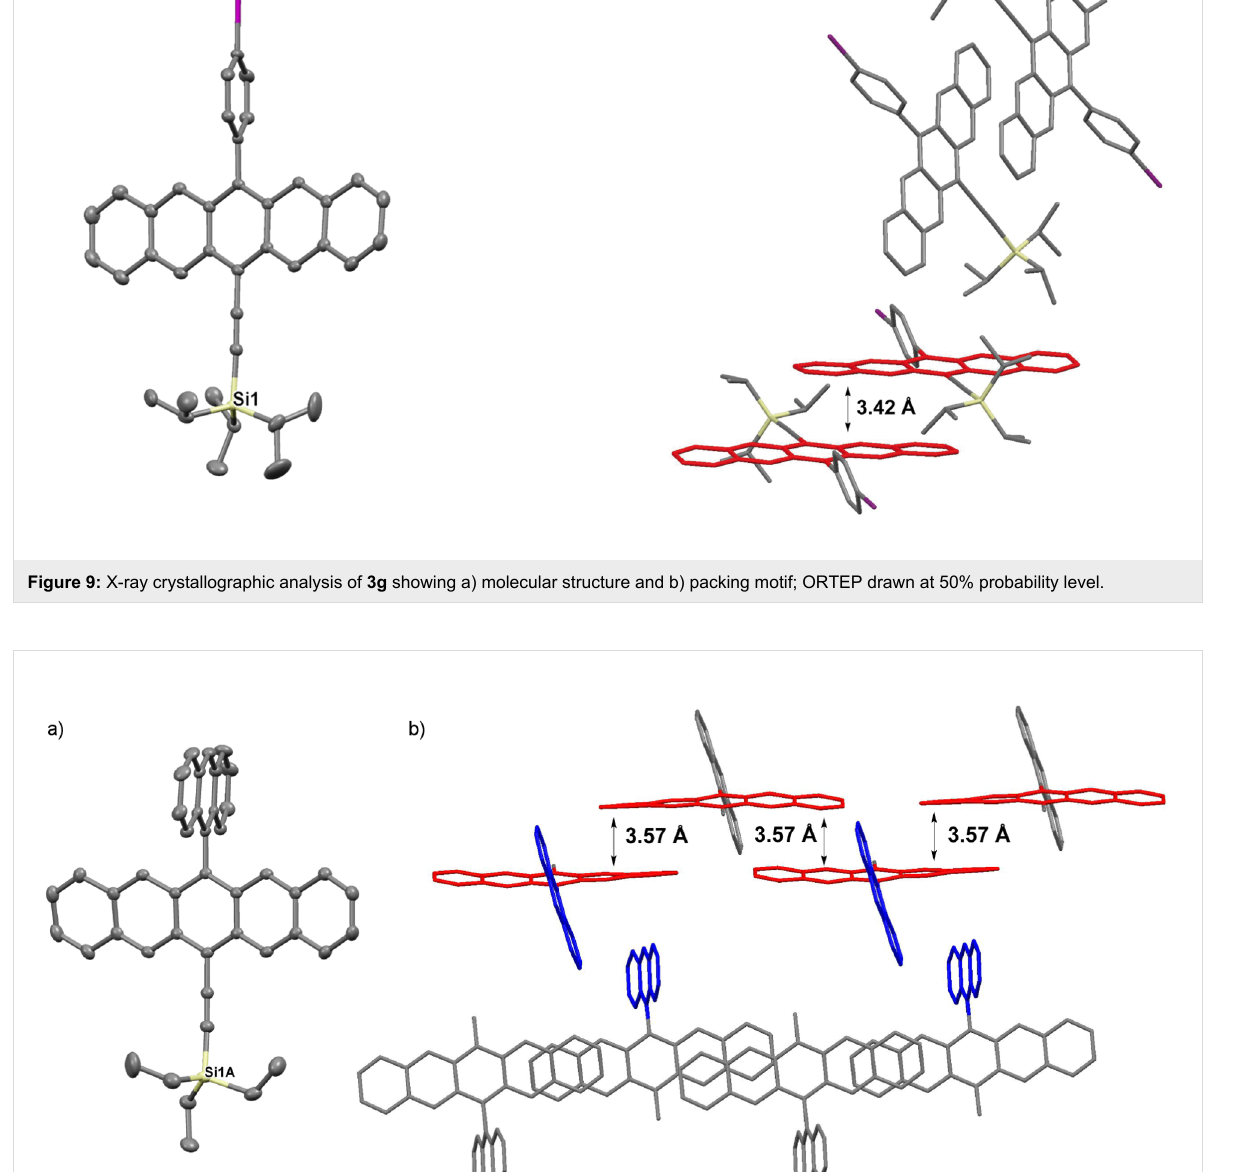
tached to the pentacene framework is nearly perpendicular to the pentacene core with an angle of ~81°, while the torsion angle between the two rings of the biphenyl unit is 32°. The biphenyl substituent is slightly bent from linearity with an angle of ~6° (as estimated from the three atoms designated with an asterisk *). Biphenyl-substituted pentacene 3i arranges in a 1D